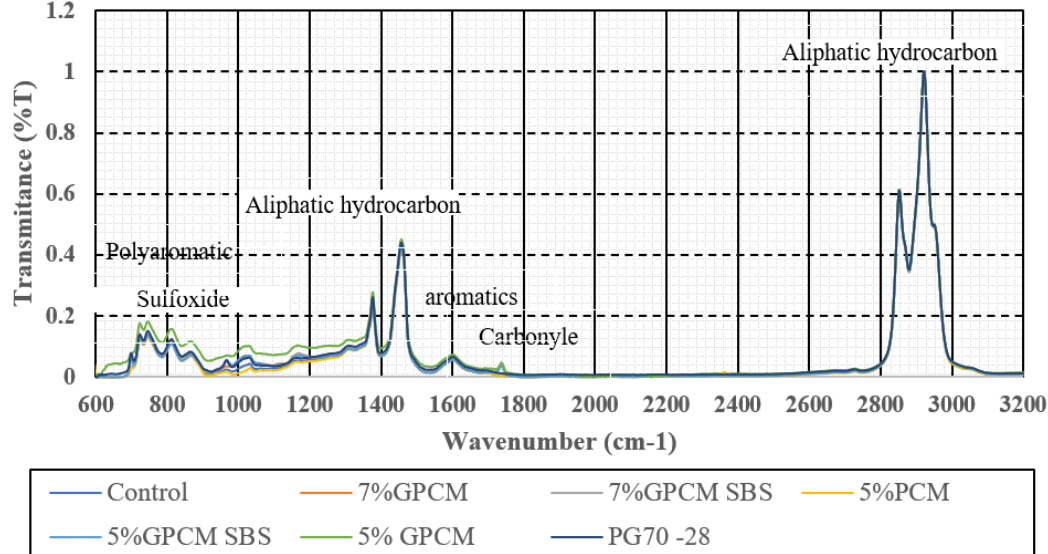
Figure 10 . FTIR spectrum for all binder samples . Figure 10. FTIR spectrum for all binder samples.